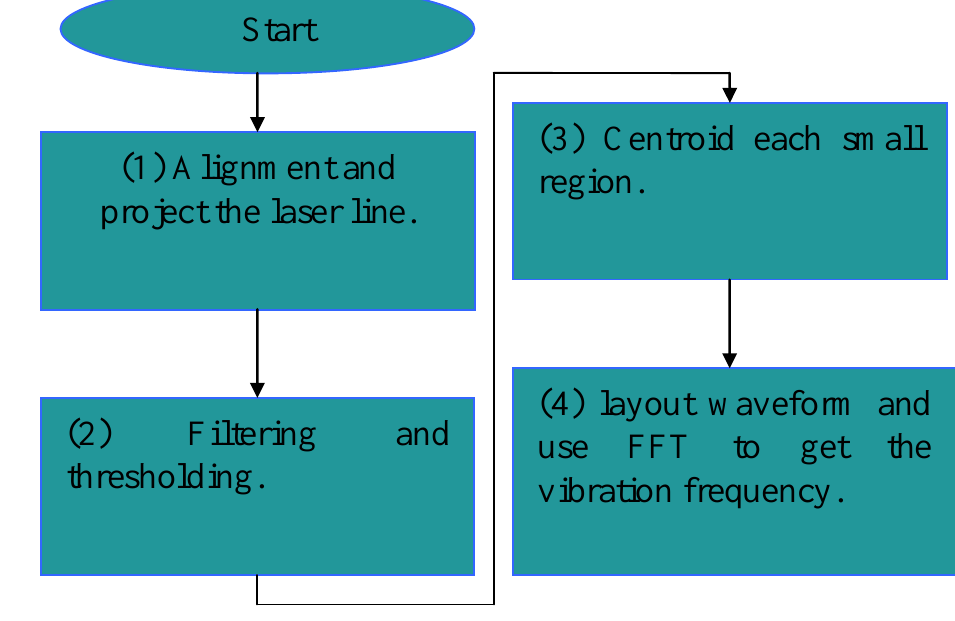
Figure 3. Signal processing flowchart for the proposed Parkinson’s disease measurement